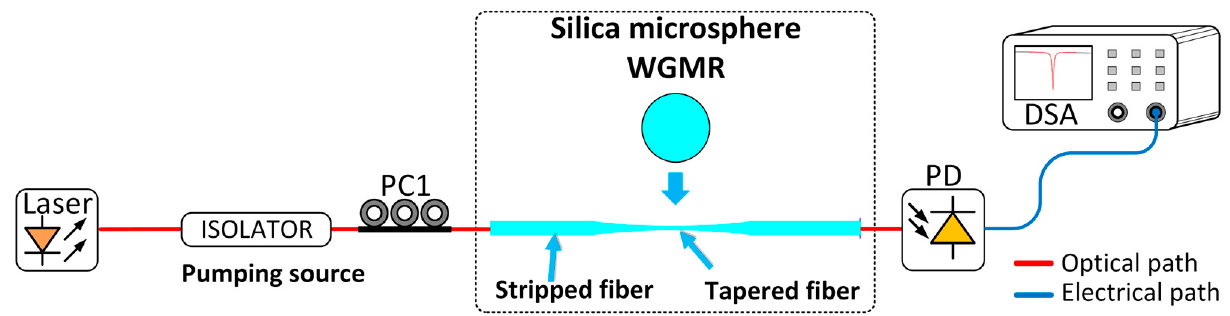
Figure 3. Experimental setup used for the characterization of the tapered fiber and silica micro- sphere.